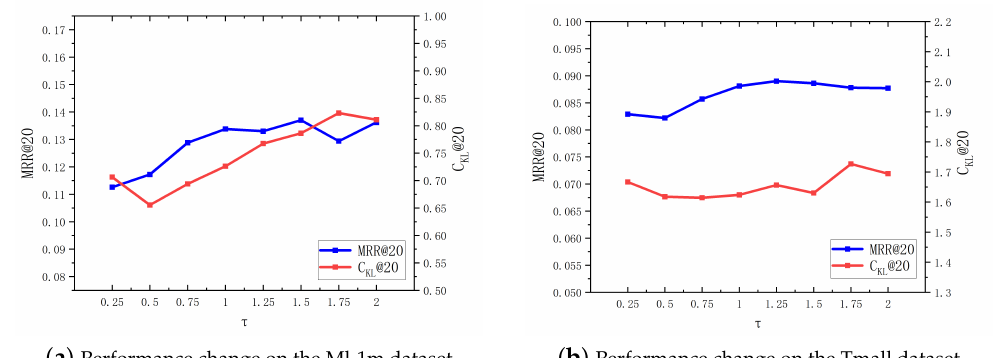
( a ) Performance change on the Ml-1m dataset ( b ) Performance change on the Tmall dataset Figure 4. Performance comparison when τ changes.